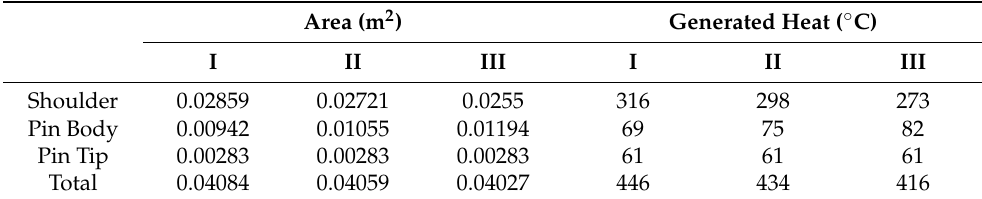
Table 2. Area of various part of tools and related generated